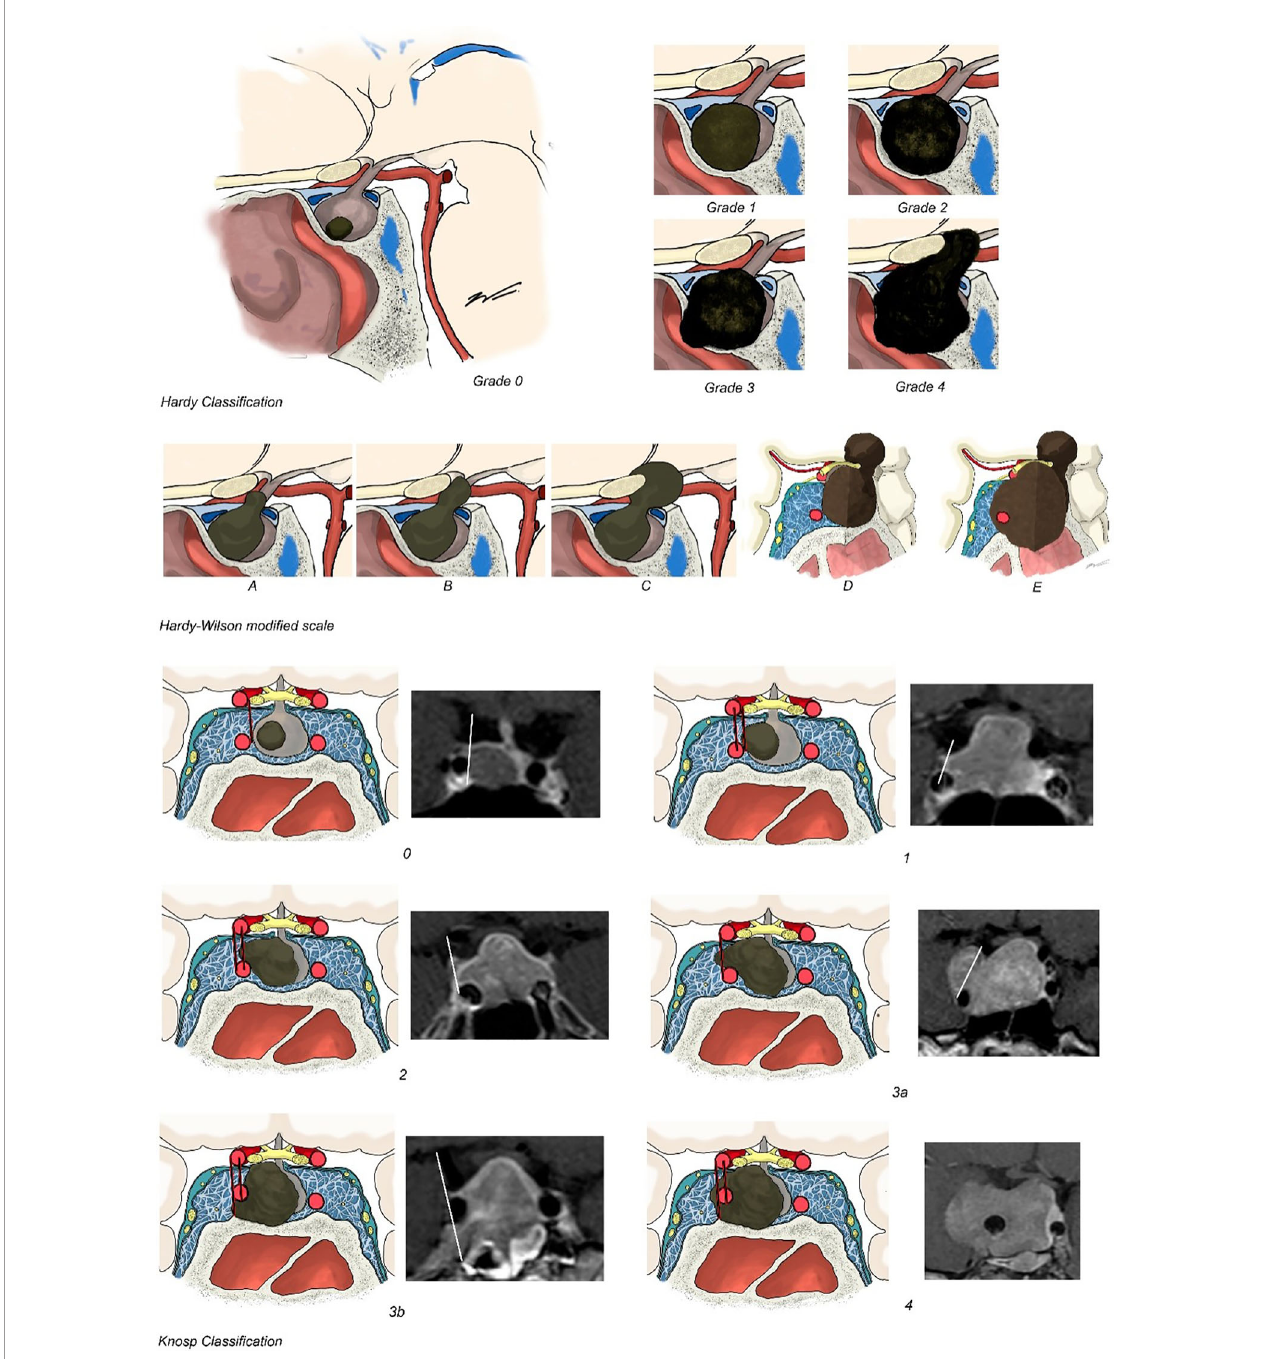
FIGURE 2 | Hardy – Wilson and Knosp classi fi cations. Hardy – Wilson classi fi cation considered the degree of sellar destruction: Grade 0 when the adenoma remains within the anatomical con fi nes of the osteoaponeural sheath of the sella turcica; Grade I: the sella turcica is within normal limits in size or focally expanded and the tumor is <10 mm; Grade II: tumor ≥ 10 mm and the sella turcica is enlarged but the fl oor remains intact; Grade III: a local erosion or destruction of the fl oor; Grade IV when the entire fl oor of the sella is diffusely eroded or destroyed. Extrasellar extension according to Hardy – Wilson is divided in stage 0, with no suprasellar extension, A – C for progressive suprasellar extension. Knosp – Steiner classi fi cation considered: Knosp 0 when PA is medial to medial tangent; Knosp 1 if PA extends to the space between the medial tangent and the intercarotid line; Knosp 2 when PA extends to the space between the intercarotid line and the lateral tangent; Knosp 3 if PA extends lateral to the lateral tangent; and Knosp 4 with a complete encasement of intracavernous ICA. Knosp score 3 – 4 were considered as invasive PA. The revised-Knosp classi fi cation includes Knosp 3A when PA is above the intracavernous ICA into the superior cavernous sinus compartment and Knosp 3B when PA is below the intracavernous ICA into the inferior cavernous sinus